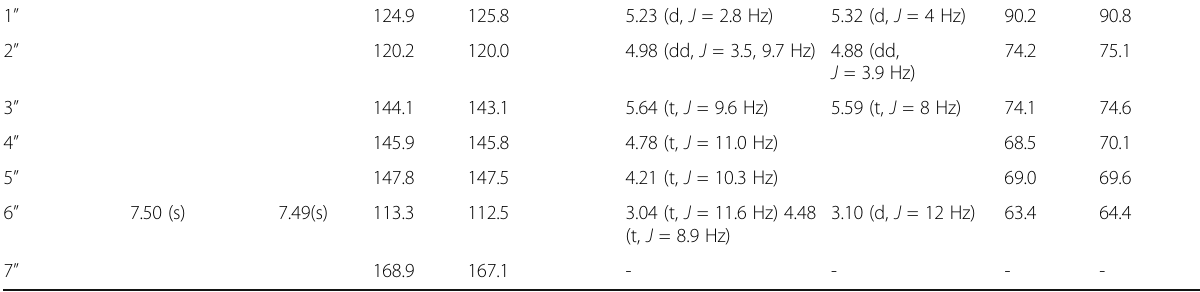
Table 2 1 H- and 13 C – NMR data of flavogallonic acid dilactone and terchebulin (in CD 3 OD) as compared with literature [16, 17]